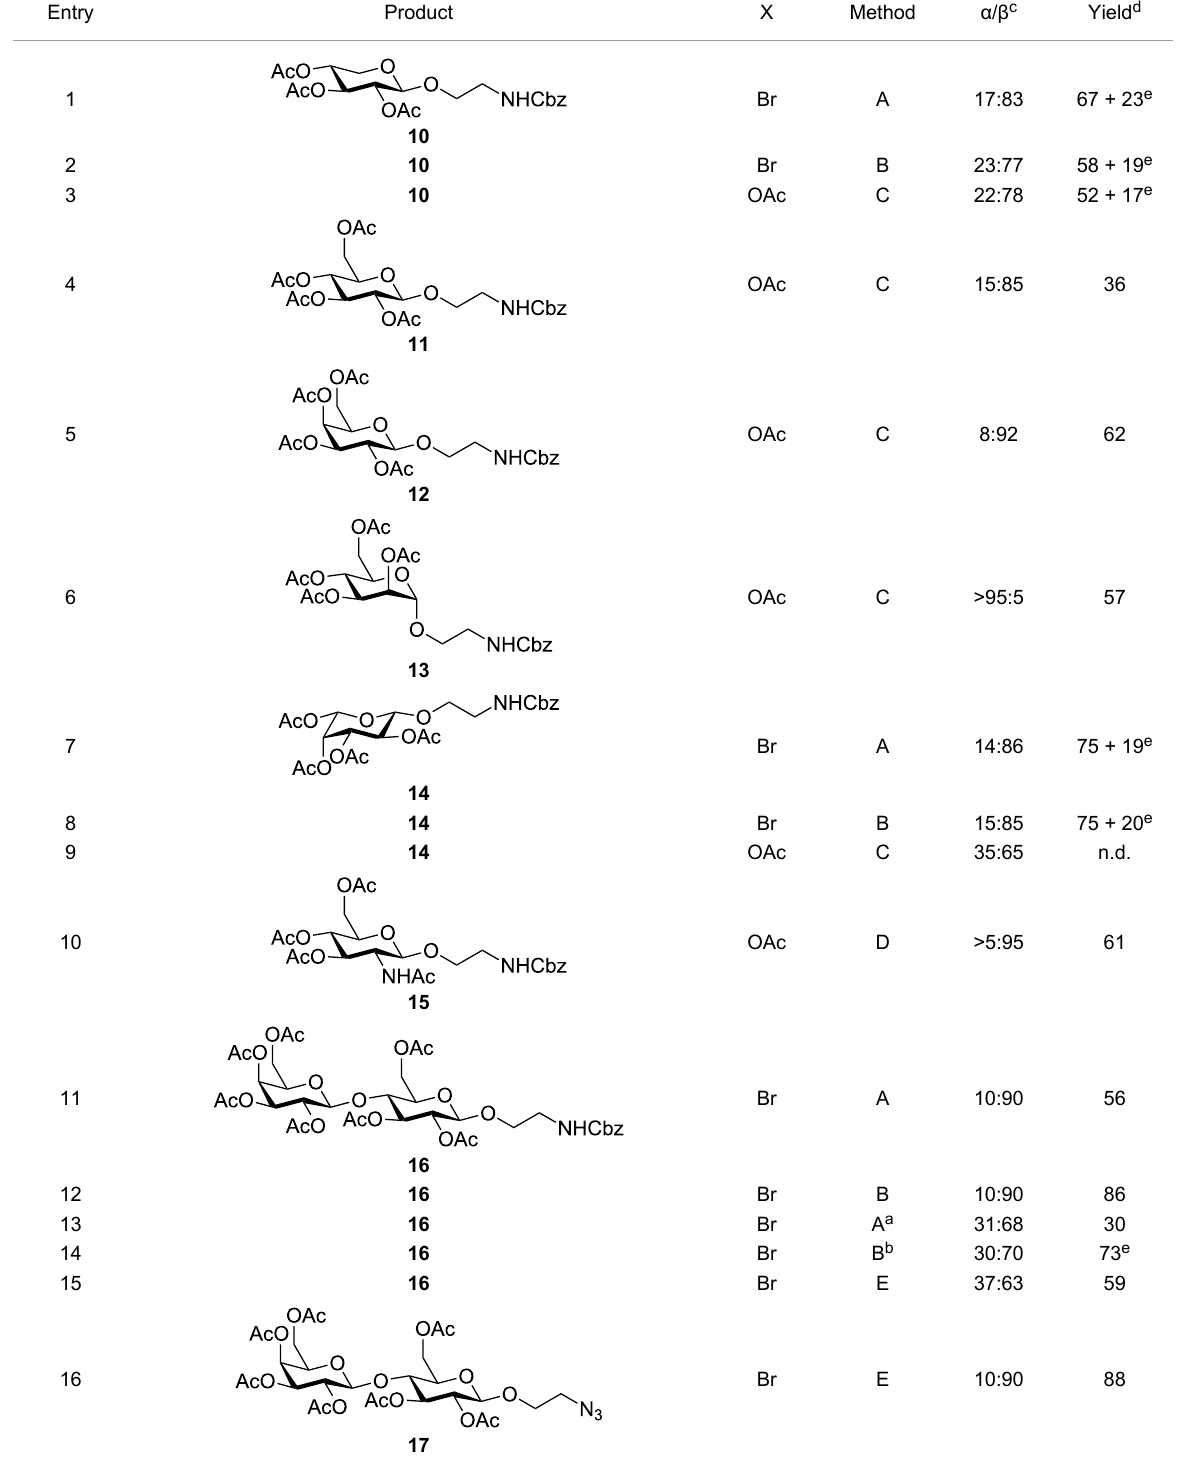
Table 1: Results of glycosylation reactions as shown in Scheme